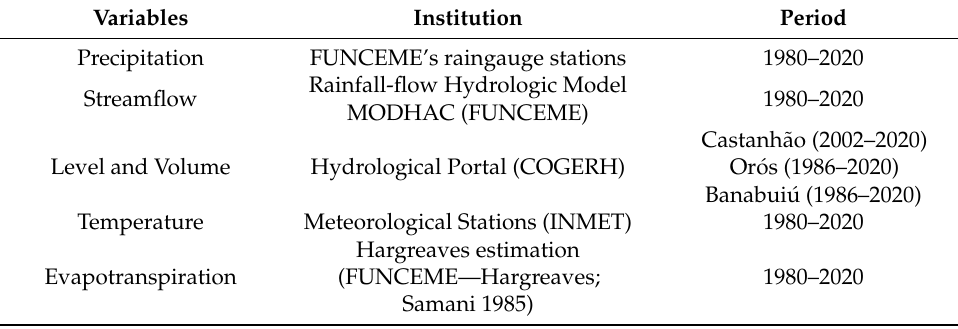
Table 1. Data used in the construction of the